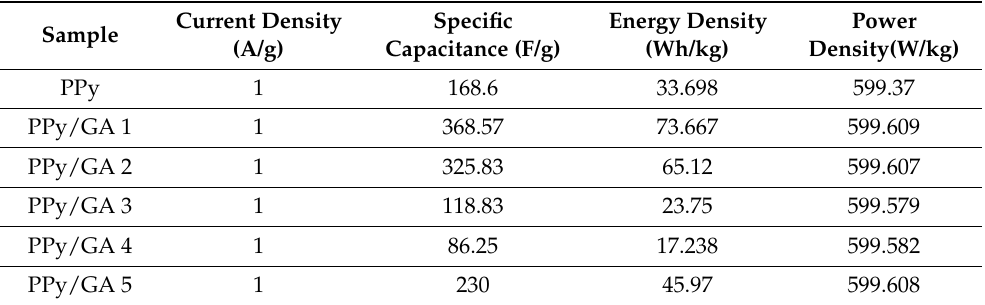
Table 3. The specific capacitance, energy density, and power density of PPy and PPy/GA